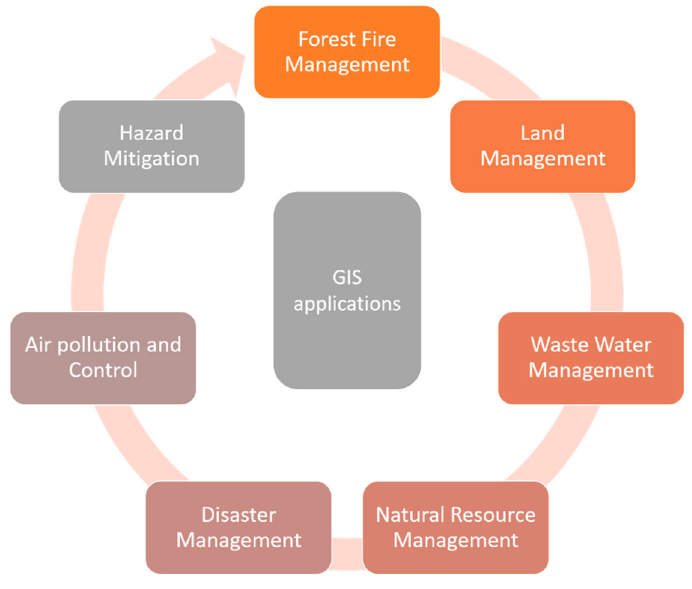
Figure 1. GIS in environmental studies (adapted from https://www.geospatialworld.net/article/gis-in-environmental-studies-an-overview/ (accessed on 20 March 2021)).